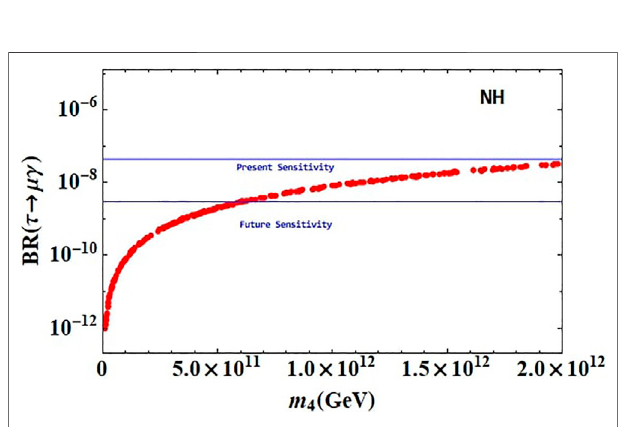
FIGURE 10 | BR ( τ − μ c ) as a function of the sterile neutrino mass. The blue horizontal line represents the experimental bounds on this process.